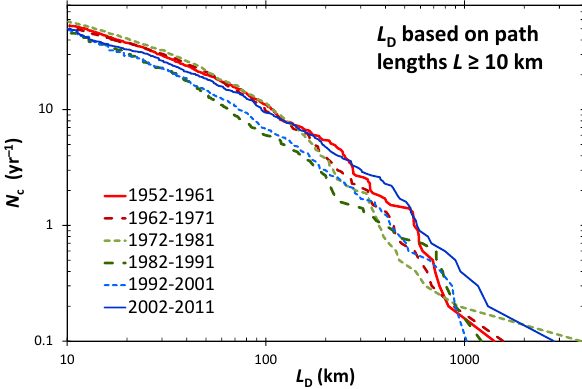
Fig. 11. For continental USA severe tornadoes ( L ≥ 10km; F j , j ≥ 0), the total path length, L D , during a convective day (12:00– 12:00 UTC) is given for the time period 1982–2011. Each L D rep- resents a quantitative measure of a USA “outbreak” of tornadoes, and is a total of severe tornado path lengths (individual path length data from NOAA, 2012) during a convective day.